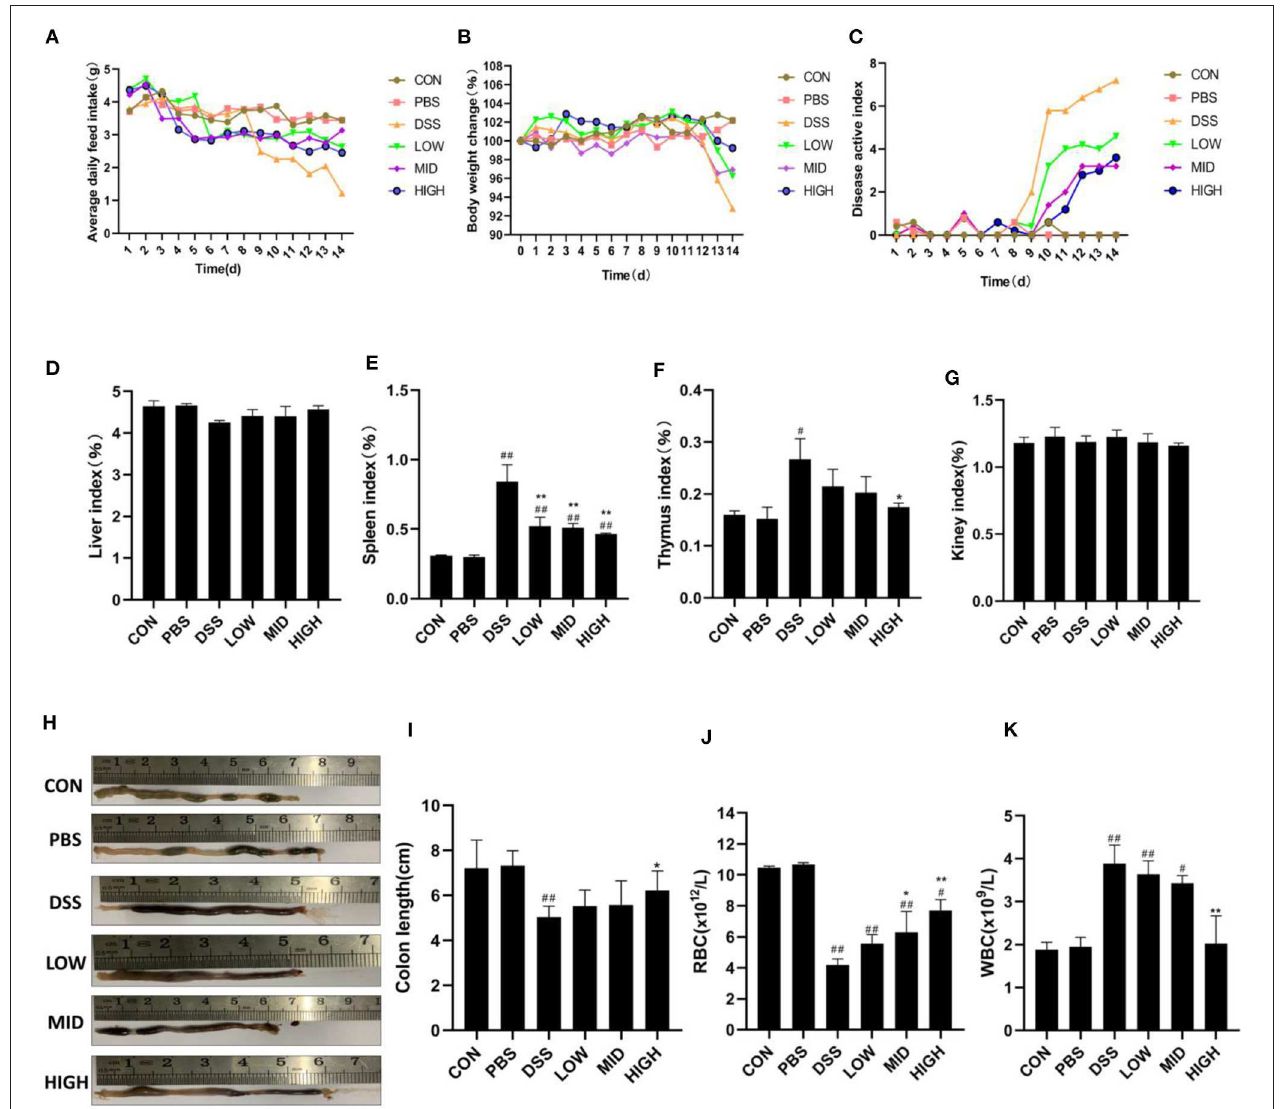
FIGURE 7 | The effect of BTL-1 on DSS-induced IBD model in mice. Mice were given DSS for 7 days with or without BTL-1, the PBS group was given only PBS, and the control group was fed normally. The effect of BTL-1 on average daily feed intake (A) , average daily gain (B) , DAI (C) , organ index (D–G) , and colon (H,I) of IBD mouse model induced by DSS. The effects of BTL-1 on blood routine examination in DSS-induced IBD mice (J,K) . The results were expressed as the means ± SEM of n = 5. # P < 0.05, ## P < 0.01, compared to control group, * P < 0.05, ** P < 0.01 compared to DSS